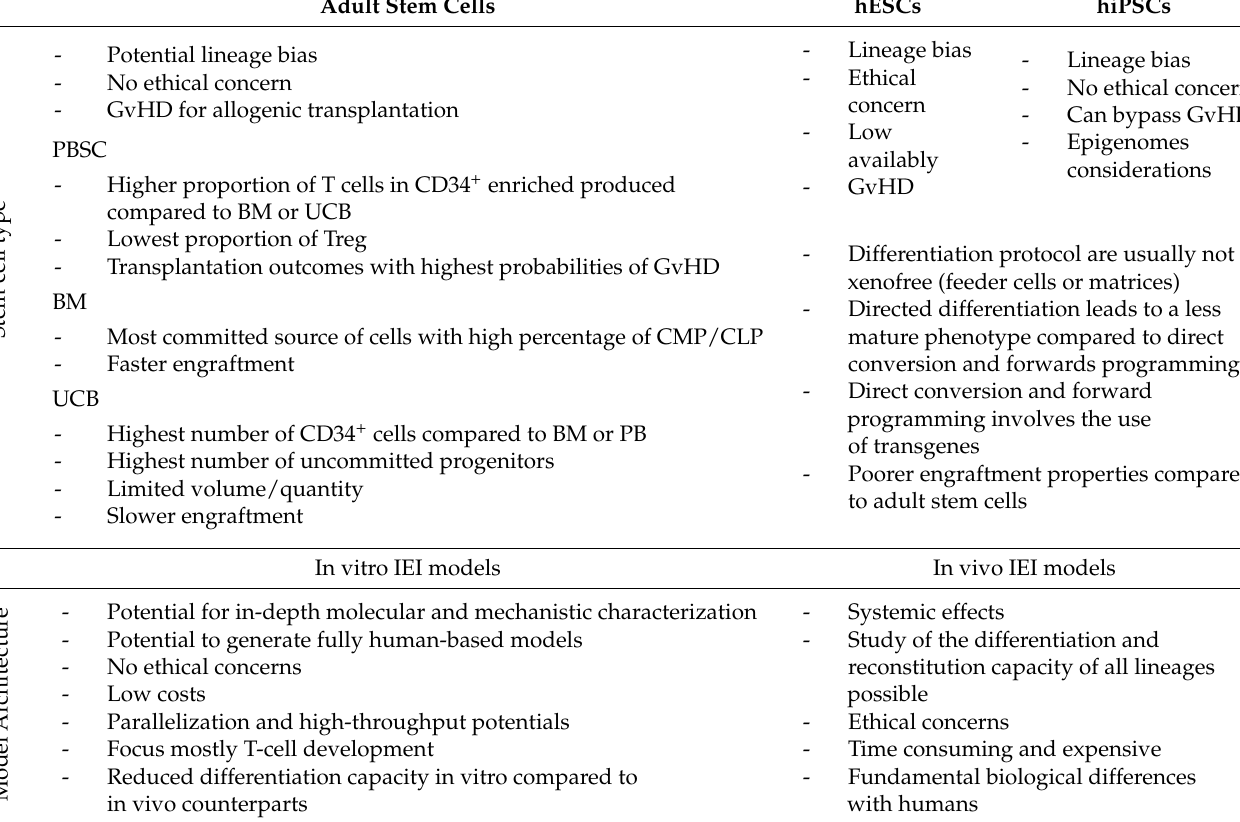
Table 1. Summary of key considerations regarding models for